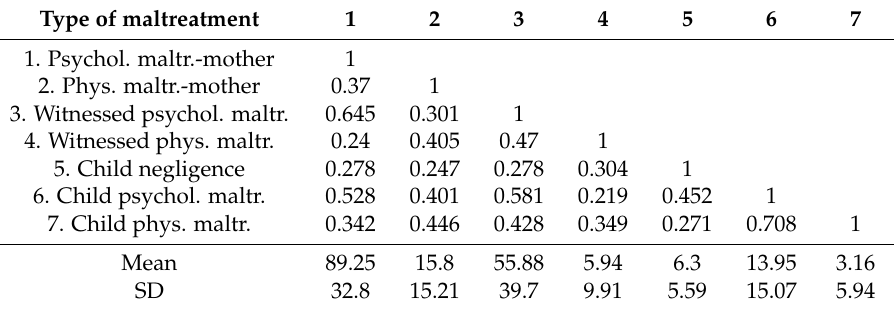
Table 4. Pearson correlation matrix of child and mother